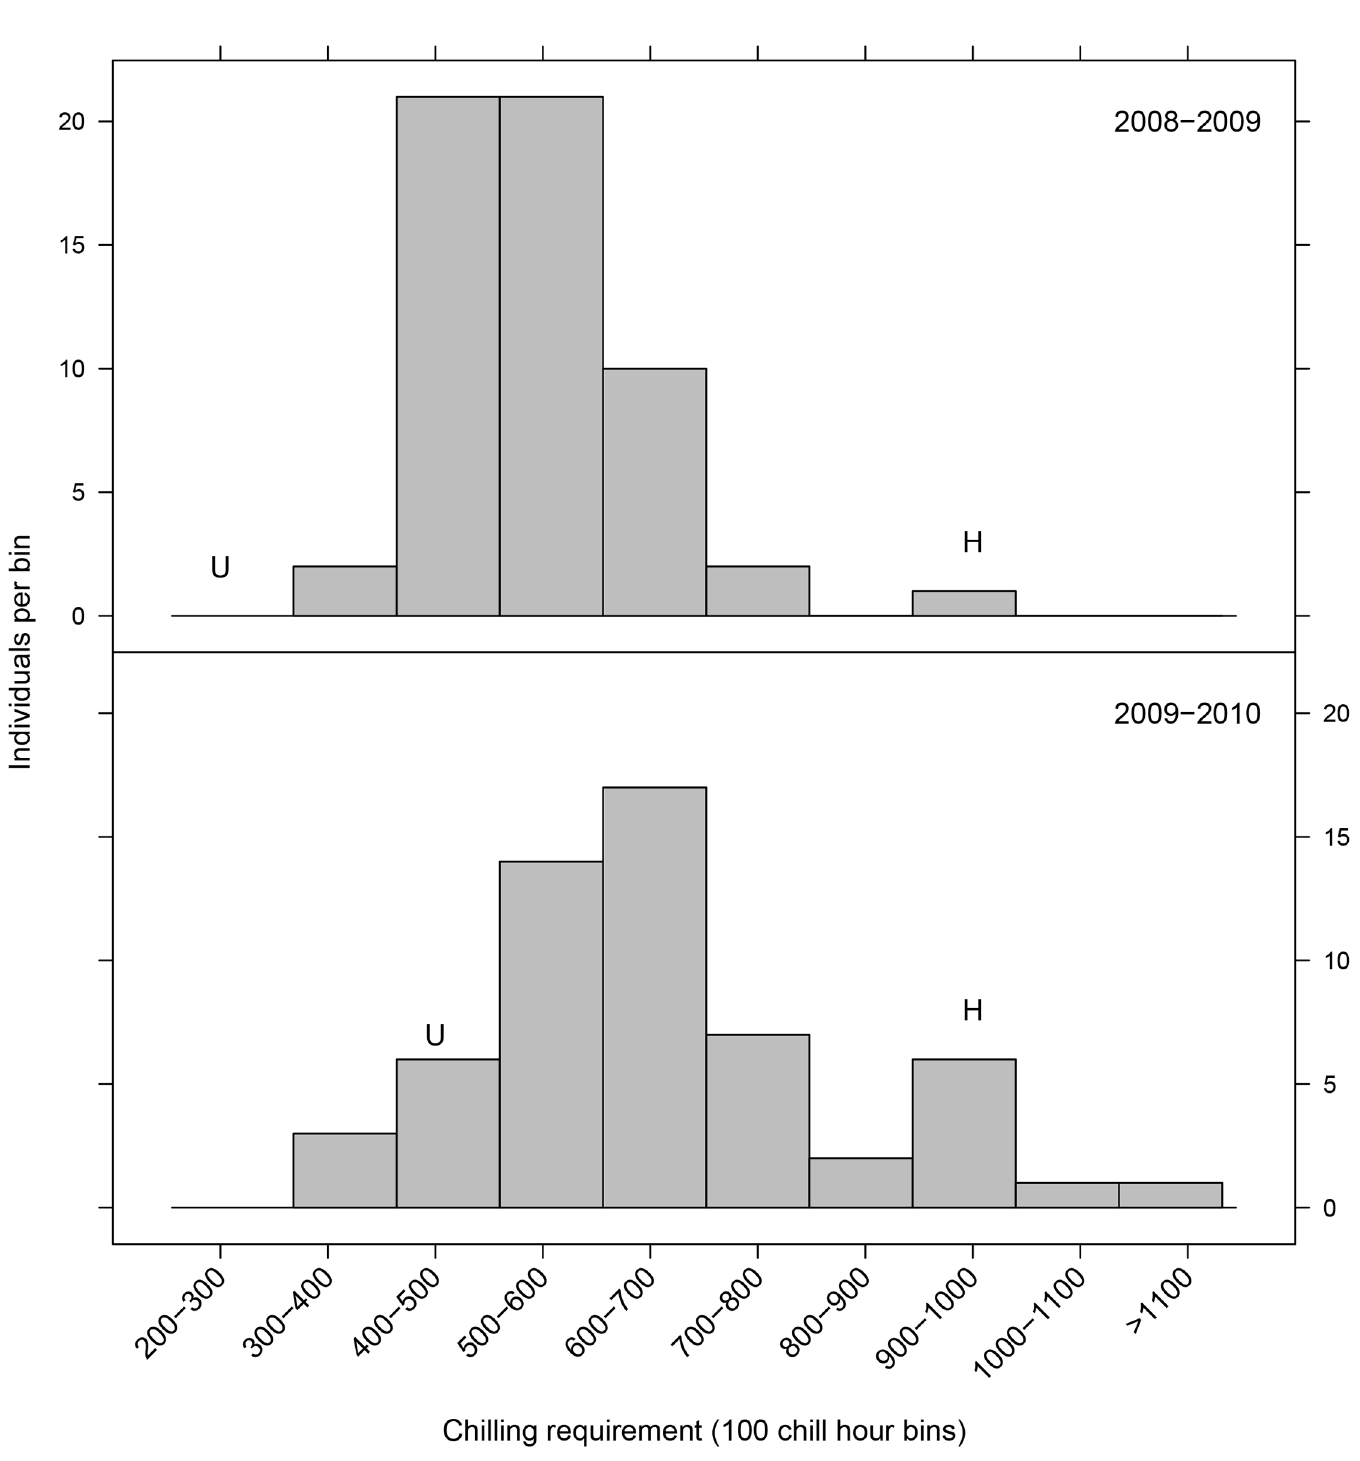
Fig 2. Histogram of chilling requirement (CR) phenotypes of F 2 progeny in 2008/2009 and 2009/2010. Bins are 100 chill hour intervals. Letters indicate grandparental phenotypes (H, ‘ Hakuho ’ ; U, ‘ UFGold ’